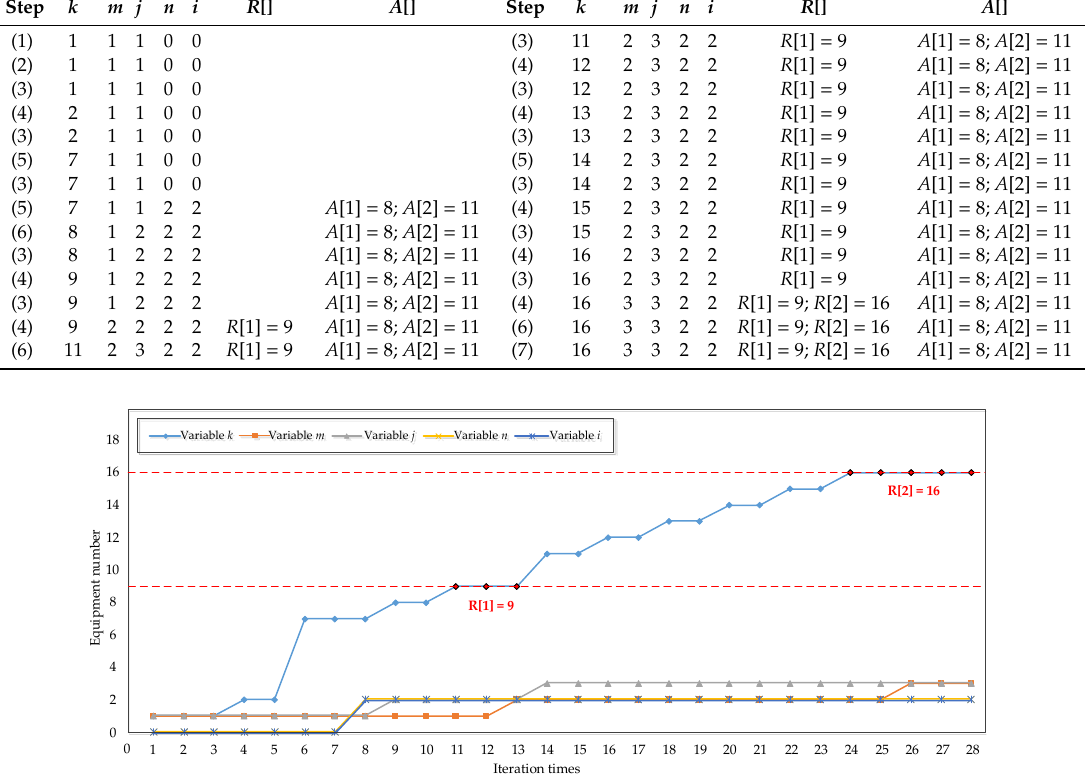
Figure 8. Iterative process of test case 2. Table 5. The operation steps of test case 2.